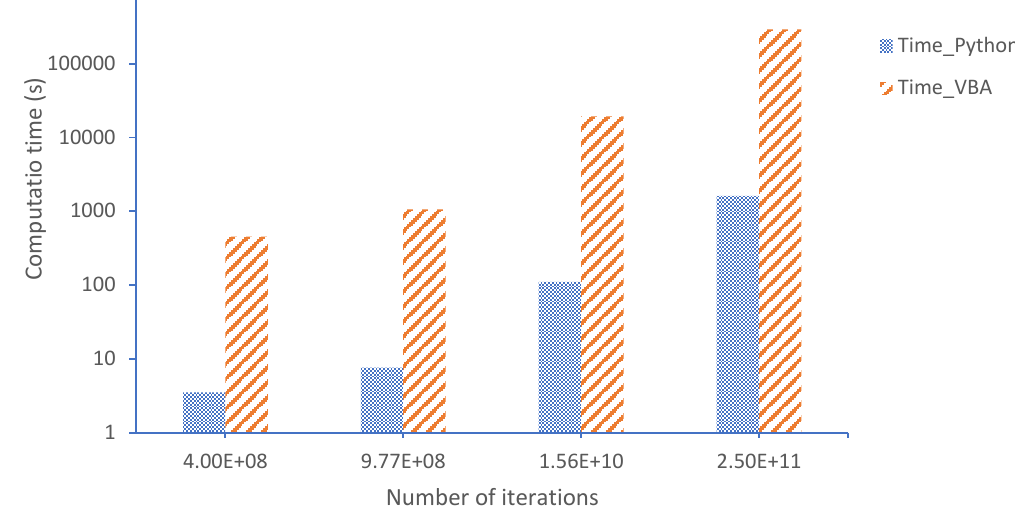
Figure 8. Computation time versus the number of iterations for a = 2 m, b = 1 m, and c = 1 m and Φ = 120°. Table 5. Simulation parameters for computation time at different element sizes.